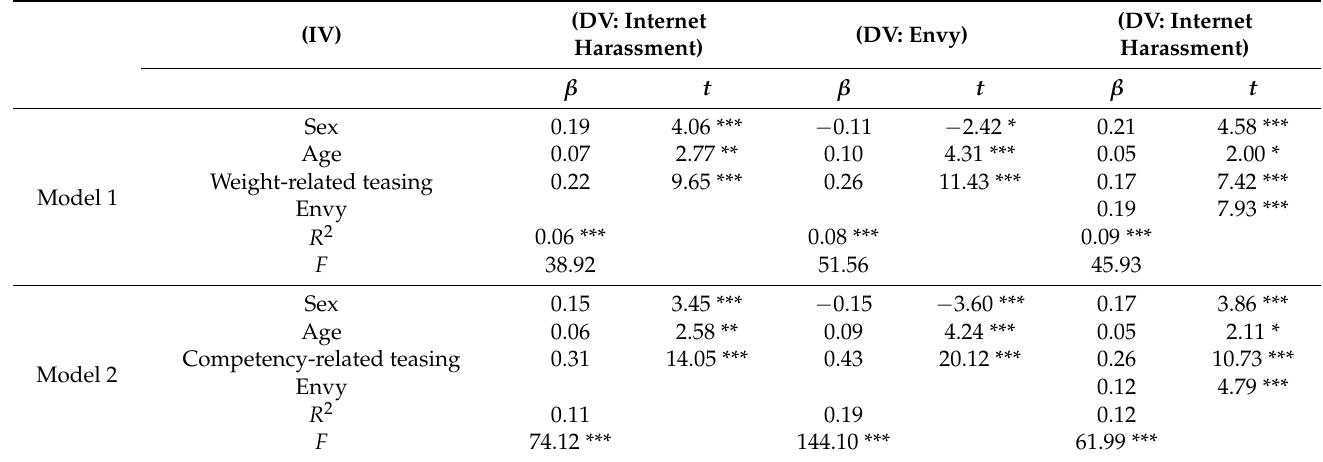
Table 2. Testing the mediation effect of weight-related/competency-related teasing on Internet harassment.